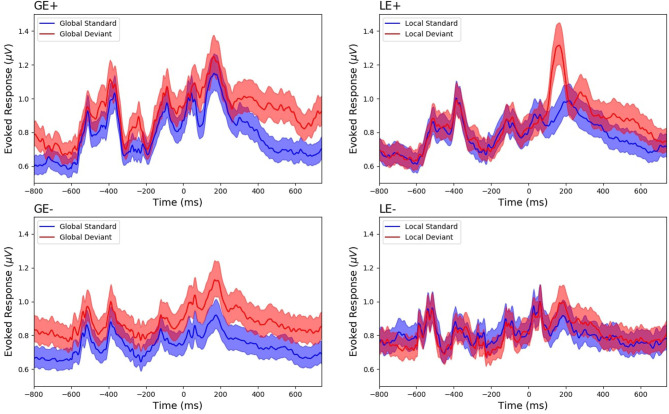
Global field power (GFP) of survivors according to their global effect (GE)(+/–) and local effect (LE)(+/–) status. GFP was computed from mean event-related potentials (ERPs) of deviant (red) and standard (blue) conditions and was plotted with a confidence interval at 95% (shaded areas), respectively, in GE+ patients (N = 40; see upper left panel), GE- patients (N = 103; see lower left panel), LE+ patients (N = 86; see upper right panel), and LE- patients (N = 57; see lower right panel). This figure is only shown to illustrate mean ERP patterns: (i) responses to each of the five sounds, (ii) contingent negative variation (CNV) component visible as a ramping ongoing slope in particular in the GE+ group, (iii) mismatch negativity (MMN)-P3a for LE+, and (iv) late P3b component in the GE+ group. No statistical test was calculated given that patients were selected for the corresponding category at the single-subject level statistics.